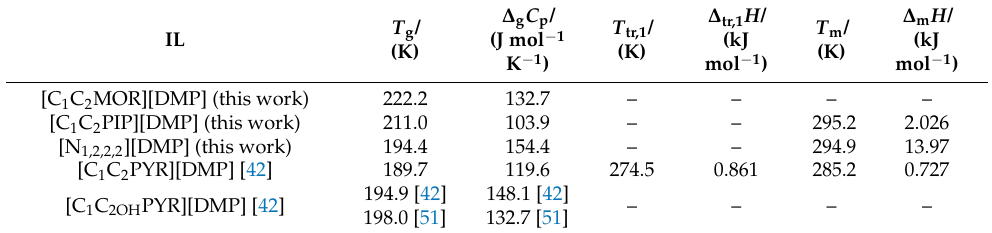
Table 1. DSC Analysis for the dimethyl-phosphate-based iLs: glass transition temperature, T g/ K, heat capacity at the glass transition temperature, ∆ g C p /J · mol − 1 · K − 1 , temperature of (solid–solid) phase transition, T tr,1 /K, enthalpy of (solid–solid) phase transition, ∆ tr,1 H/ J · mol − 1 , melting temperature, pressure ( p = 0.1 mPa) a .